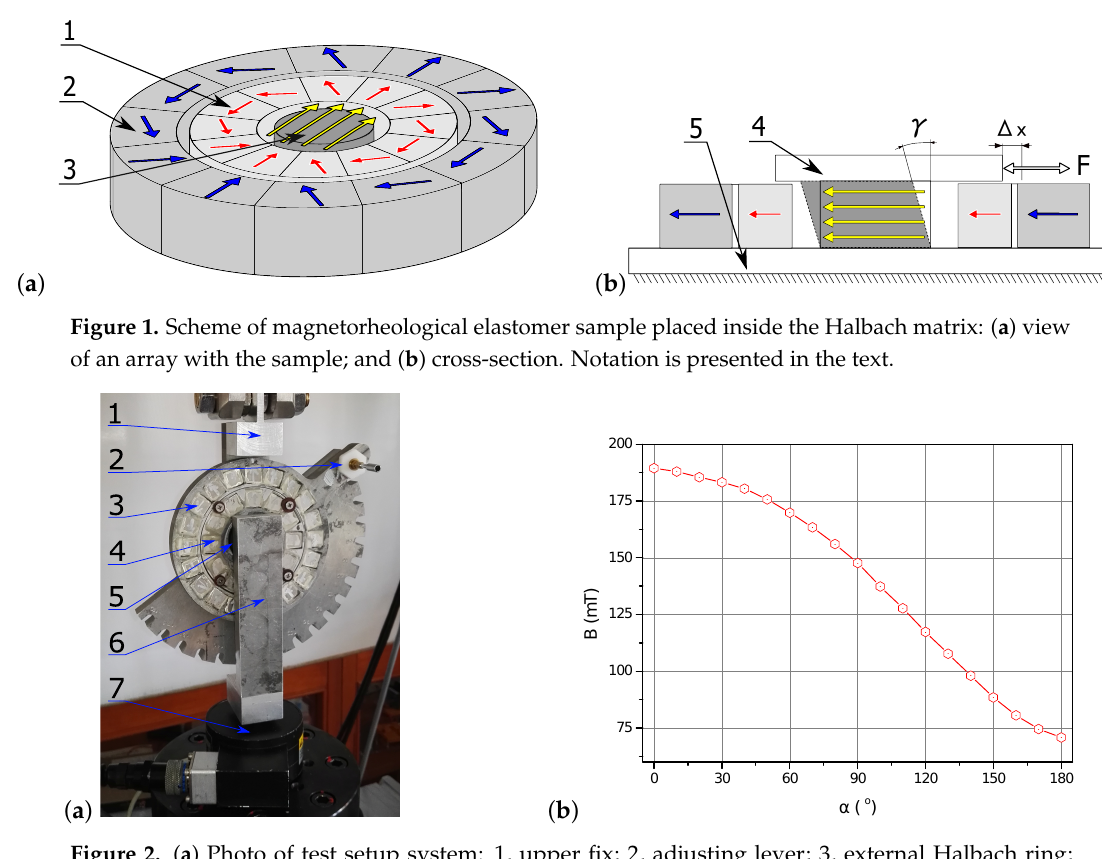
Figure 2. ( a ) Photo of test setup system: 1, upper fix; 2, adjusting lever; 3, external Halbach ring; 4, external Halbach ring; 5, specimen; 6, lower fix; 7, force transducer. ( b ) Characterization of magnetic field dependence on rotation angle α of external ring Halbach